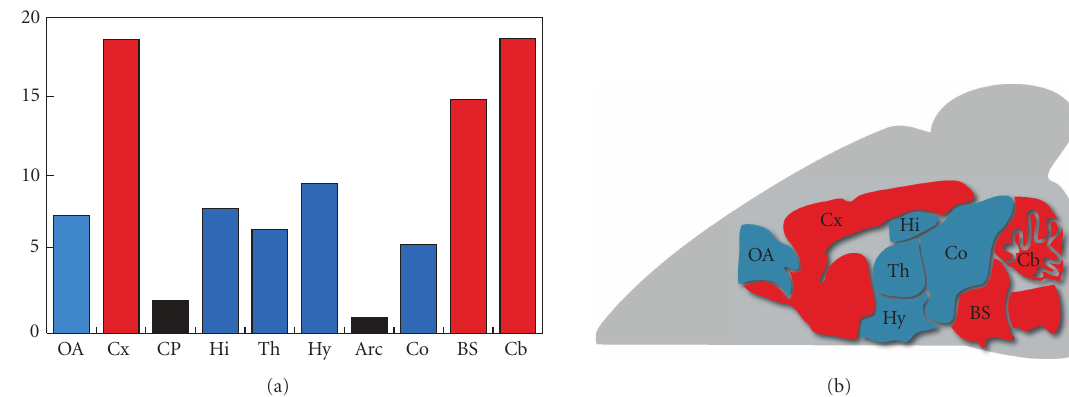
Figure 1: Expression of PPAR β in the adult mouse brain . Quantitative and spatial expression of PPAR β in the mouse brain: (a) Quantitative RT-PCR data, (b) Brain sagittal section. Moderated expression levels are in red and weak expression in blue. OA: olfactory areas, Cx: cerebral cortex, CP: caudate putamen, Hi: hippocampus, Th: thalamus, Hy: hypothalamus, Arc: arcuate nucleus, Co: colliculus, BS: brain stem, Cb: cerebellum. (MousePat: http://www-mci.u-strasbg.fr/mousepat/- consulted